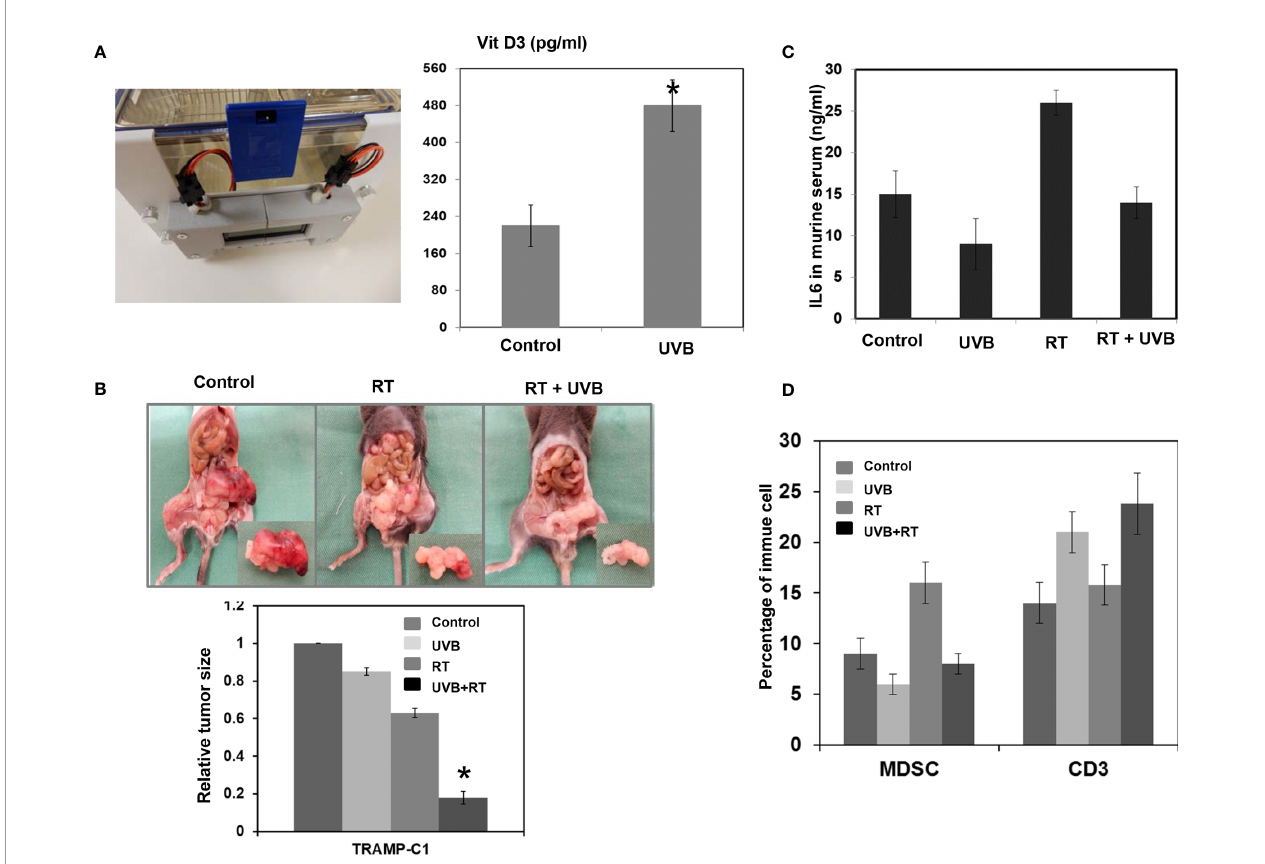
FIGURE 6 | UVB treatment reduces IL-6 production and increase the radiosensitivity of prostate cancer. (A) UVB light treatment for 5 days increased calcitriol serum levels in C57/BL6 mice. Sham irradiation was performed as a control. (B) The representative picture of orthotopic tumor at 12 days after 15Gy irradiation with or without UVB treatment. The relative tumor size was normalized to the TRMP-C1 tumor size 12 days after sham irradiation. (C) The levels of IL-6 in murine were examined by ELISA in mice. Columns represent the means ± SD. *P < 0.05. (D) UVB treatment was associated with attenuated myeloid-derived suppressor cells (MDSC) recruitment and increased in fi ltration of CD3+ T cells in tumors by